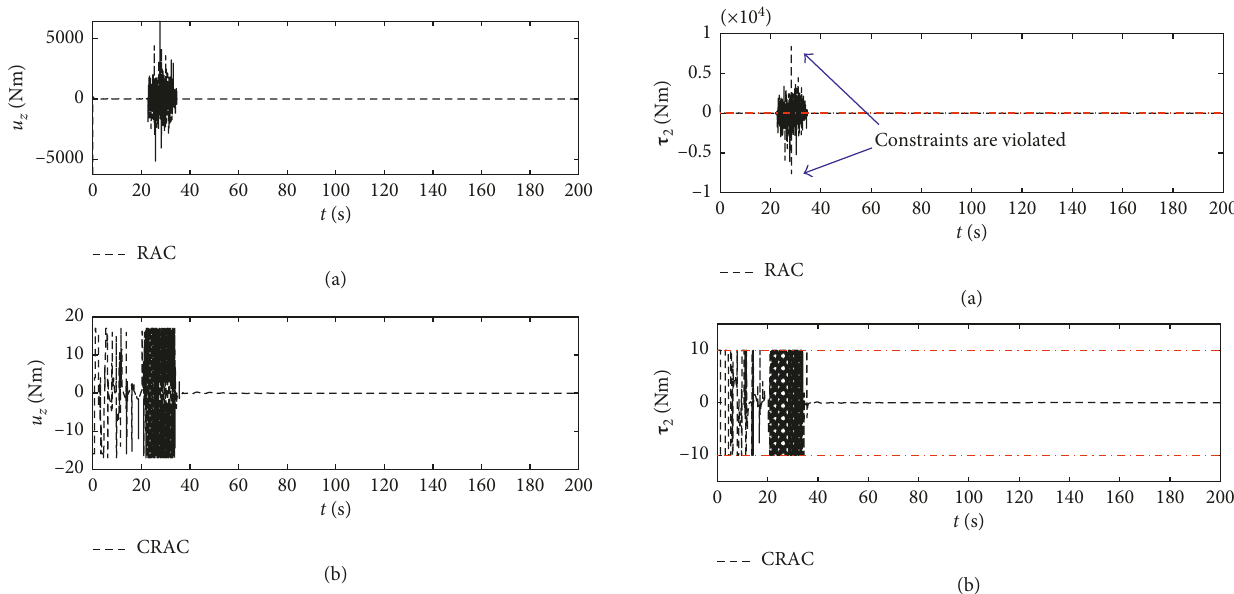
Figure 16: Time response of required control torque u